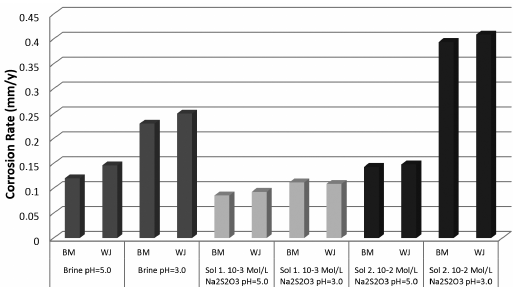
Figure 4. Average corrosion rates obtained by weight loss tests in different solutions.